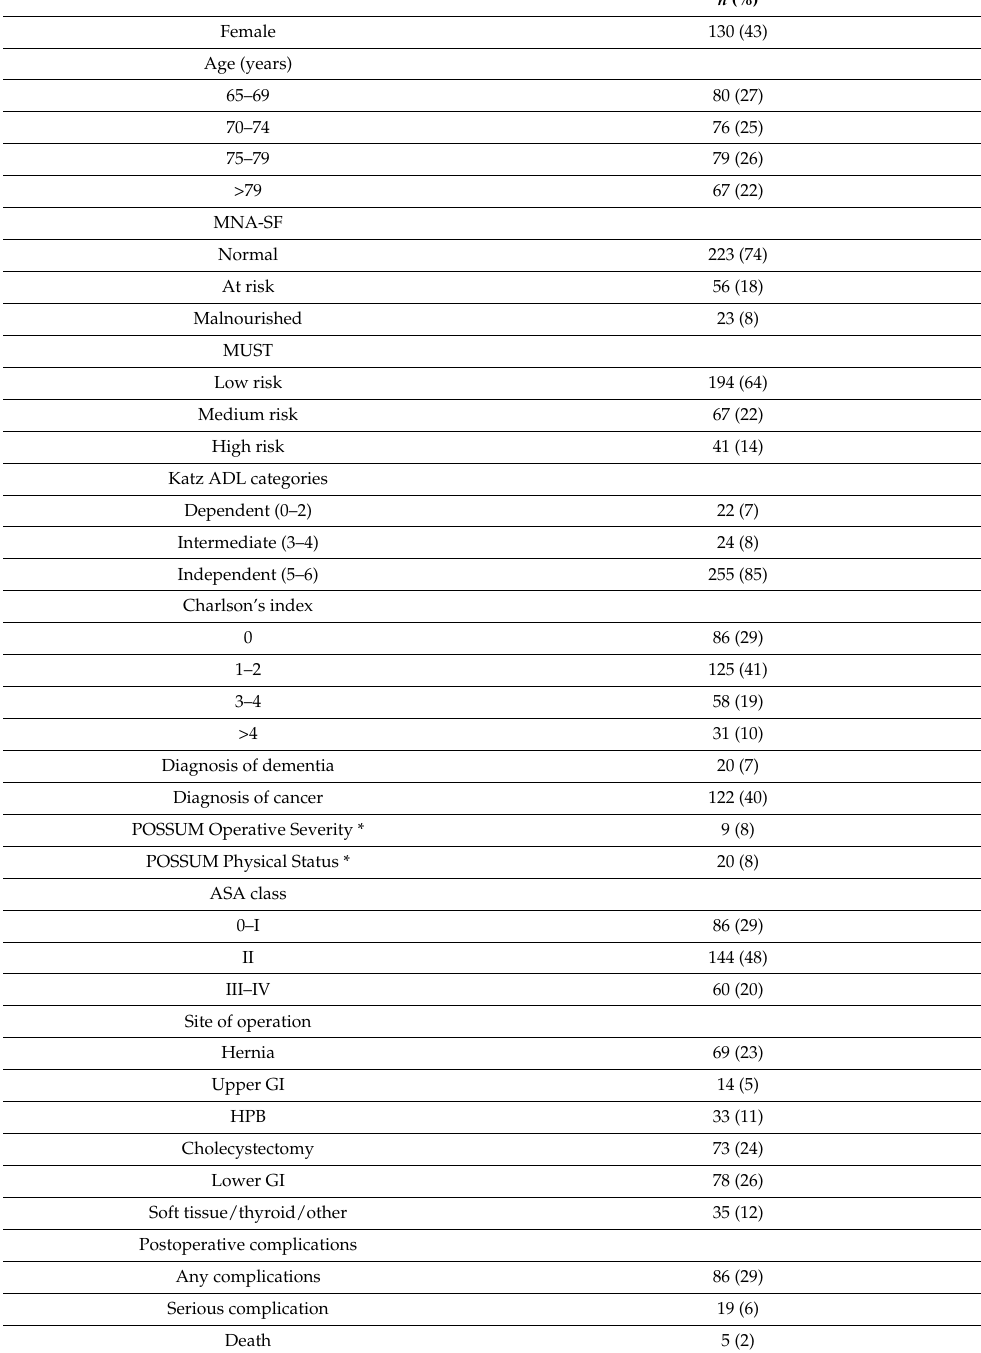
Table 1. Baseline clinical characteristics of 302 elderly patients undergoing general